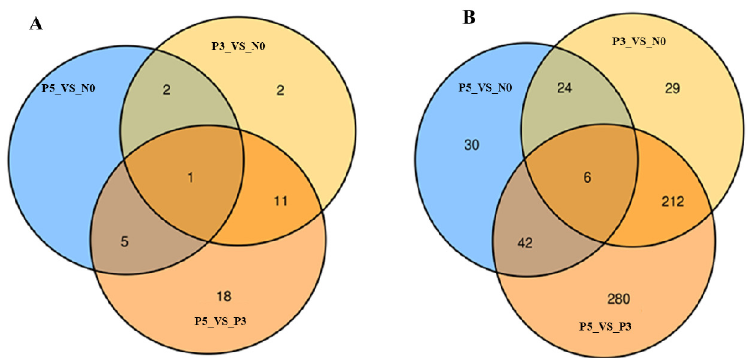
Figure 4. Identification of time point specific di ff erent expression miRNAs in PPR vaccine virus inoculated PBMC. Venn diagram displaying the total number of identified time point specific di ff erent expression ( A ) known miRNAs and ( B ) novel miRNAs. P3_VS_N0 represents PPR vaccine virus inoculated PBMC at 3 dpi compared with 0 dpi, P5_VS_N0 represents PPR vaccine virus inoculated PBMC at 5 dpi compared with 0 dpi, and P5_VS_P3 represents PPR vaccine virus inoculated PBMC at 5 dpi compared with 3 dpi.